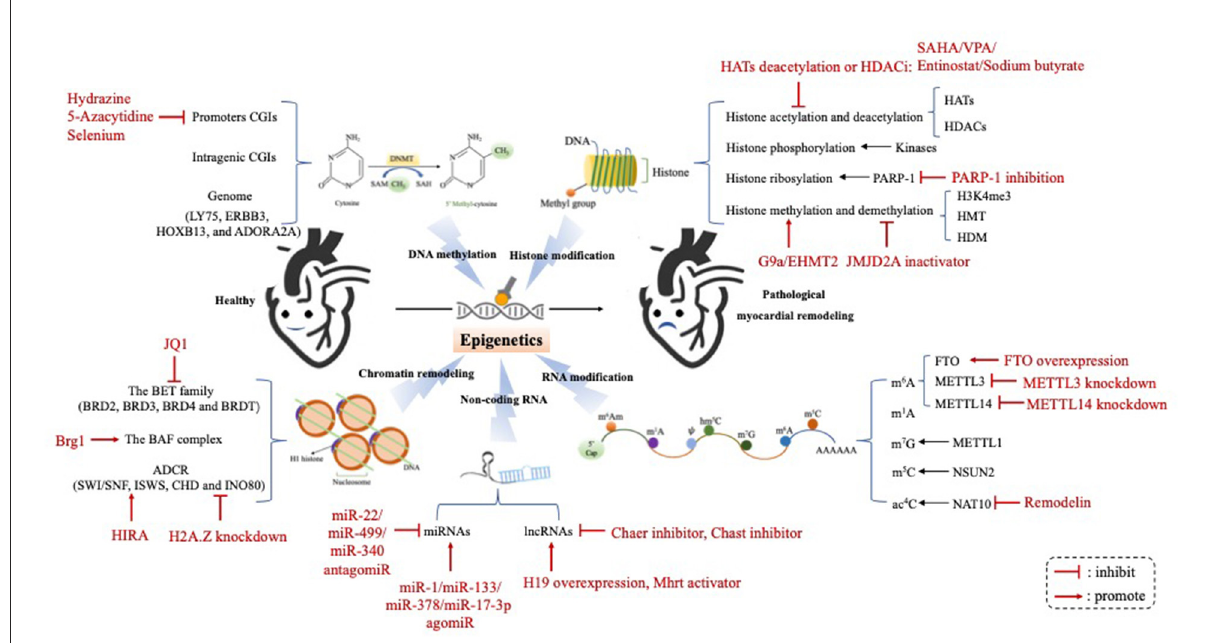
FIGURE1 The epigenetic mechanism underlying the occurrence and progression of pathological myocardial remodeling. Epigenetic regulation underlying the development of pathological myocardial remodeling can be divided into four different molecular levels: (1) DNA methylation; (2) Histone modification; (3) Chromatin remodeling; (4) Non-coding RNA; (5) RNA modification. HATs, histone acetyltransferases; HDACs, histone deacetylases; PARP-1, poly (ADP-ribose) polymerase-1; H3K4me3, histone 3 lysine 4 triamcinolone; HMT, histone methyl transferase; HDM, histone trimethyldemethylase; FTO, Fat mass and obesity-associated protein; METTL3, methyltransferase-like 3; METTL14, methyltransferase-like 14; m 6 A, N 6 -methyladenosine; m 1 A, N 1 -methyladenosine; m 7 G, N 7 -methylguanosine; m 5 C, 5-methylcytosine; ac4C, N 4 -acetylcytidine; miRNAs, microRNAs; lncRNAs, long ncRNAs; Chast, cardiac hypertrophy-associated transcript; Chaer, cardiac-hypertrophy-associated epigenetic